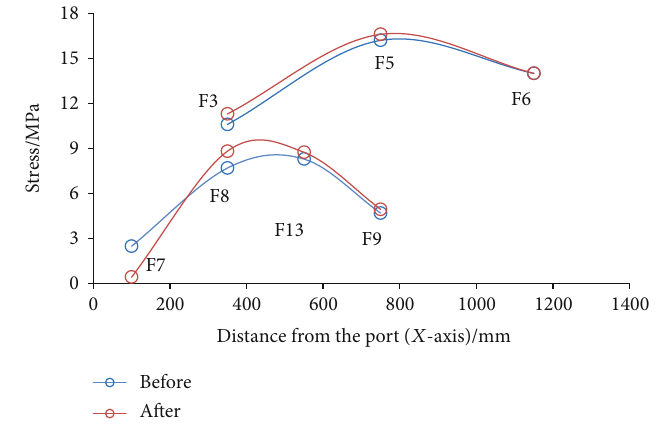
Figure 10: Stress of observation points in similar materials before and after gas